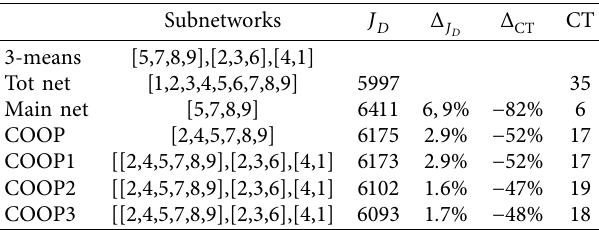
Table 4: Decentralized vs centralized with 3-means adjacent